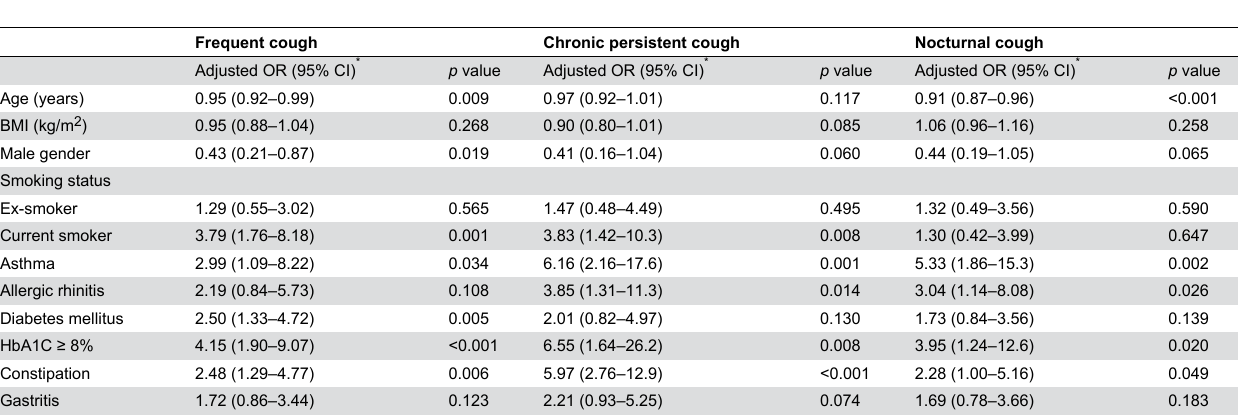
Table 3. Adjusted logistic regression models for cough and comorbidity relationships.